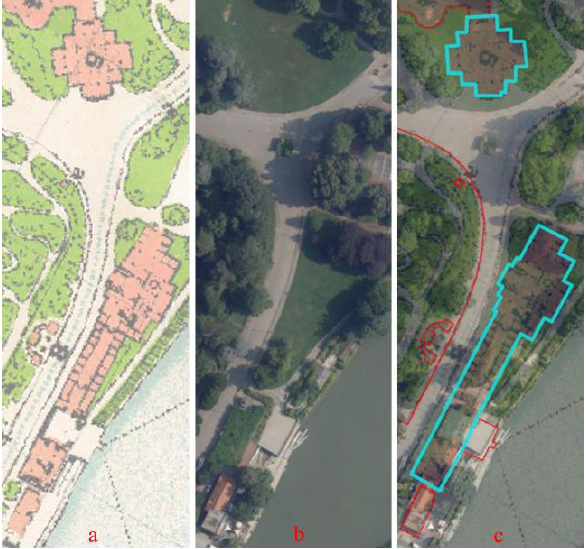
Figure 16. Georeferencing in GIS of the (a) historical map on (b) the orthophoto of the actual Valentino Park to (c) overlay the two data; Pavilions of Hungary and City of Turin are highlighted with light blue boundaries